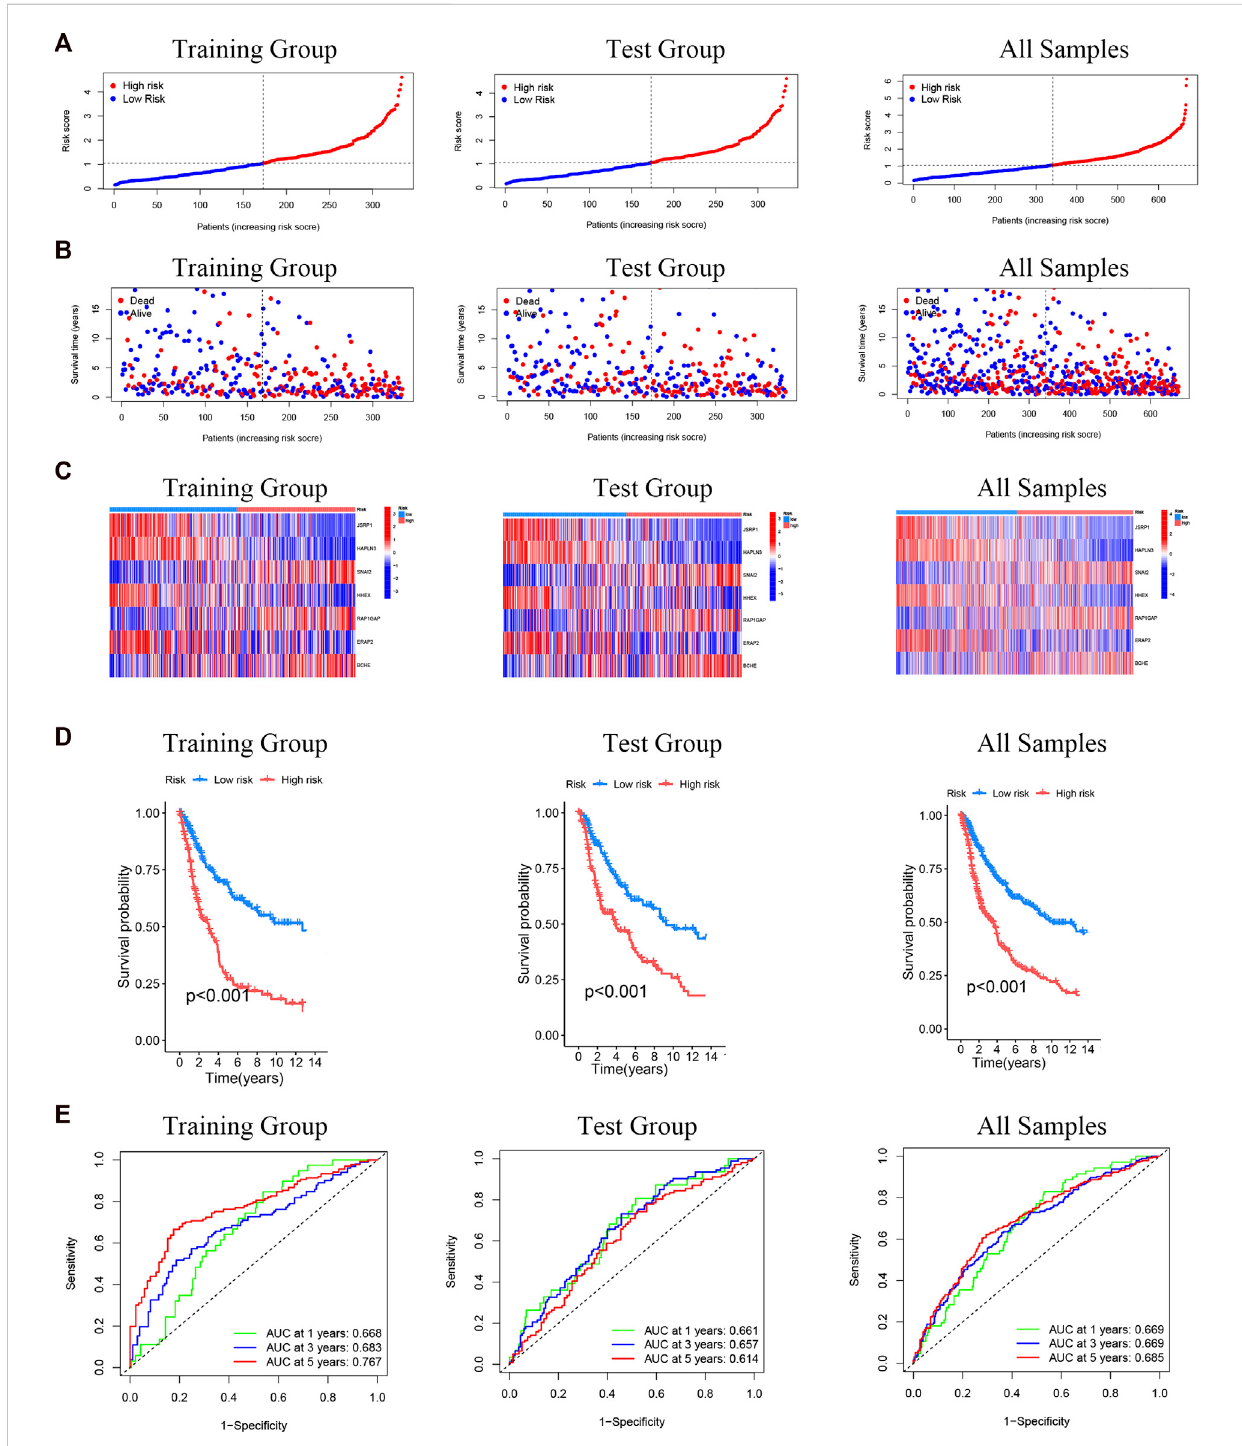
FIGURE 7 Prognostic evaluation of cuproptosis-related differential genes nomogram in melanoma patients. (A) Risk score distribution of two risk groups. (B) The scatter chart shows the distribution of OS and different risk groups. (C) The expression of the seven cuproptosis-related differential genes in the risk model. (D) K-M survival curve of melanoma patients in different risk scoring groups. (E) ROC curves for training group and test group (including all